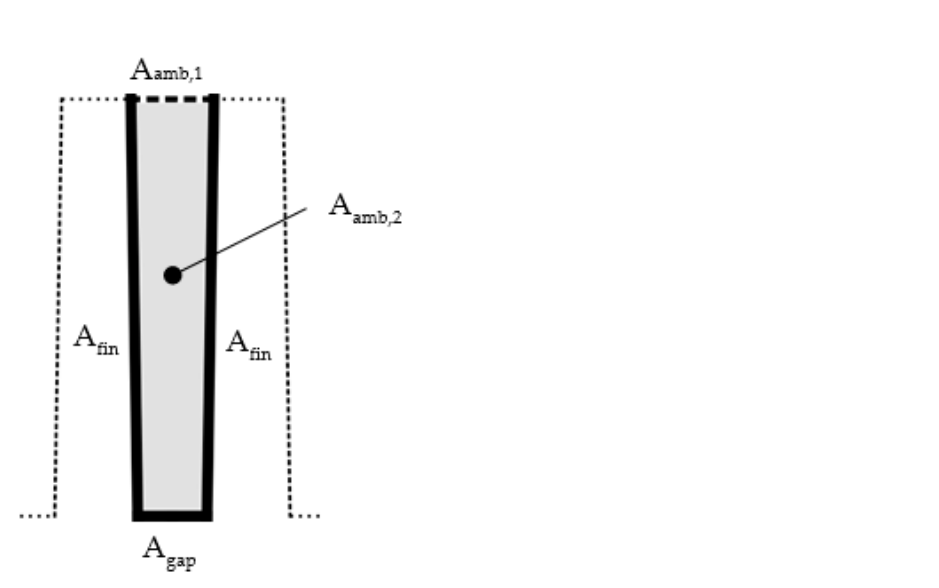
10 of 13 Figure 14. Fins’ surfaces (red) whose radiative heat transfer coefficient needs to be adjusted due to their mutual radiation. Therefore, the ambient view factor, 𝐹 (cid:3028)(cid:3040)(cid:3029) , is calculated for these surfaces. The factor represents the fraction of ambient which is visible from the surface. Its simplified evalua-